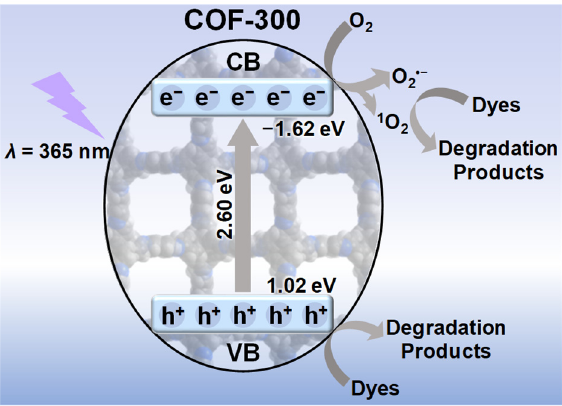
Figure 7. The schematic illustration for the generation of reactive species and photocatalytic dye degradation mechanism of COF-300.